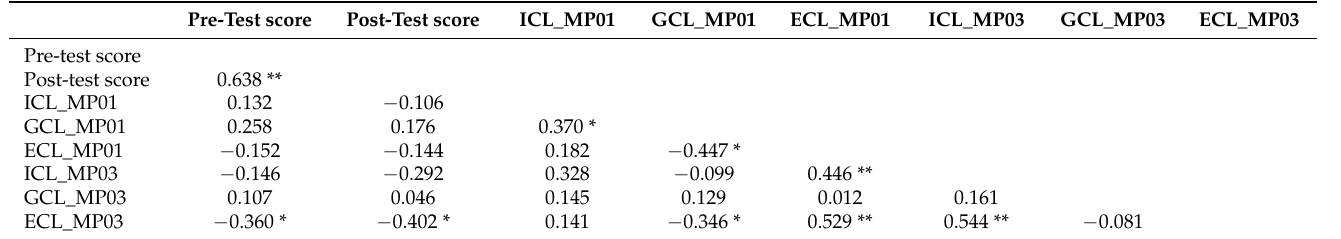
Table A2. Pearson correlations of domain-specific knowledge and cognitive load for the AR